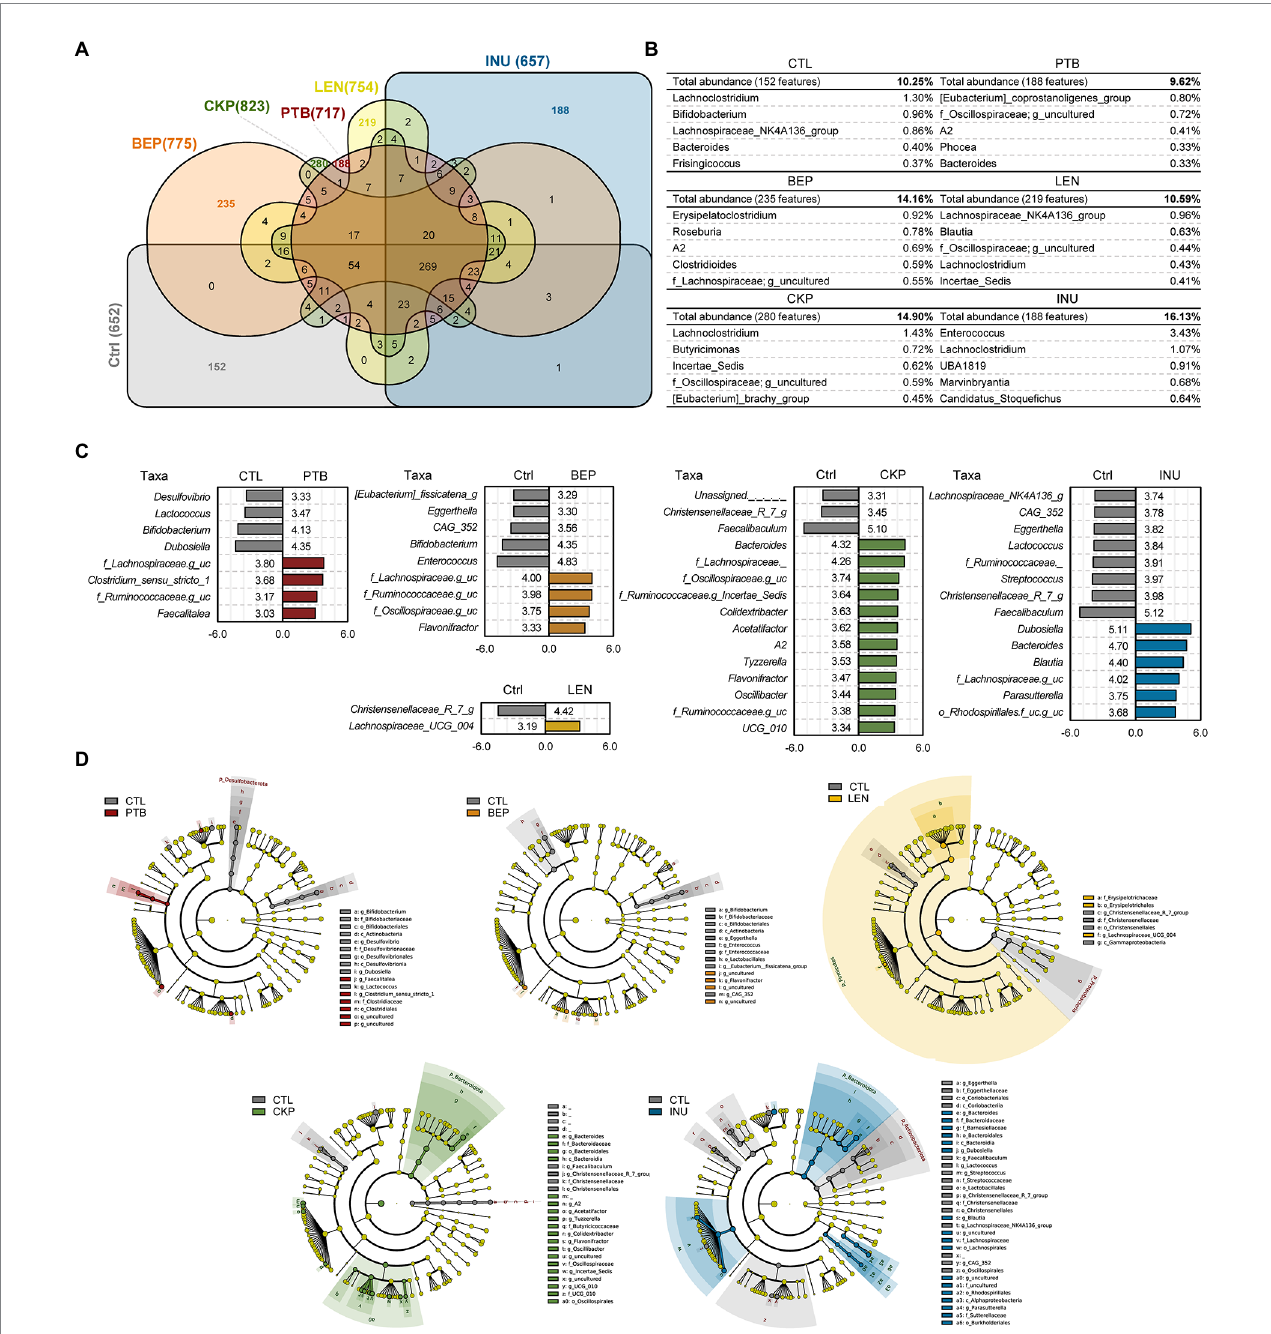
FIGURE 3 Comparison of unique microbiome features and discriminatory taxa between prebiotics (resistant starches and inulin) versus control groups. (A) Venn diagram illustrating unique and shared features (ASVs) among different groups. (B) Unique features expanded to display top 10 genera with relative abundance of unique features of each group. (C) Bacterial composition differences between groups analyzed with Linear discrimination analysis (LDA) effect size (LefSe) algorithm; x -axis: LDA score. (D) LEfSe cladogram depicting differentially abundant taxa between groups. PTB, Pinto beans; BEP, black-eyed peas; LEN, Lentils; CKP, chickpeas; INU, inulin; CTL, control high-fat diet